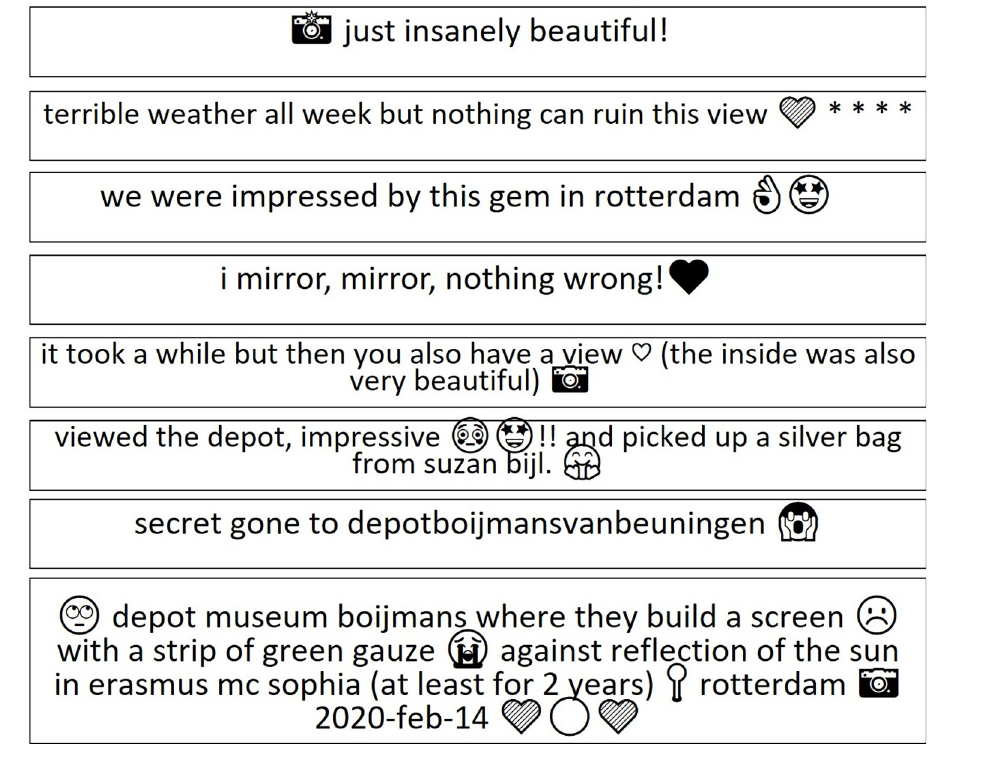
Fig 12. A selection of comments with emojis (by